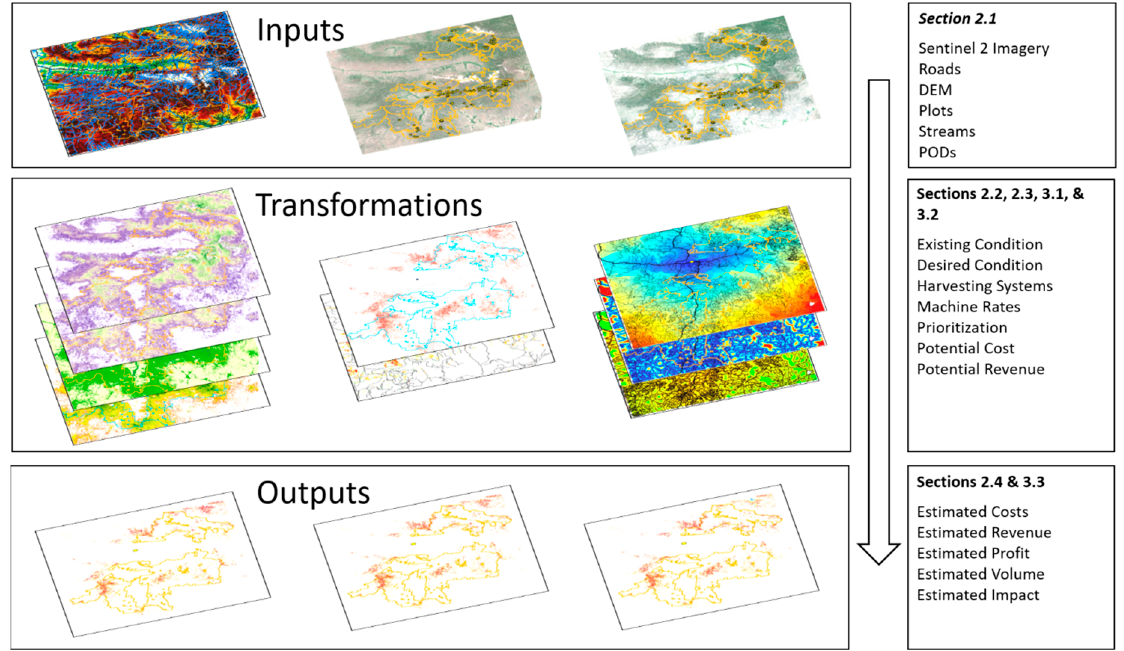
Figure 1. Organizational diagram visually depicting the flow of analyses, various inputs, transformations, and outputs, and the subsection within the article where descriptions of methods and results can be found.